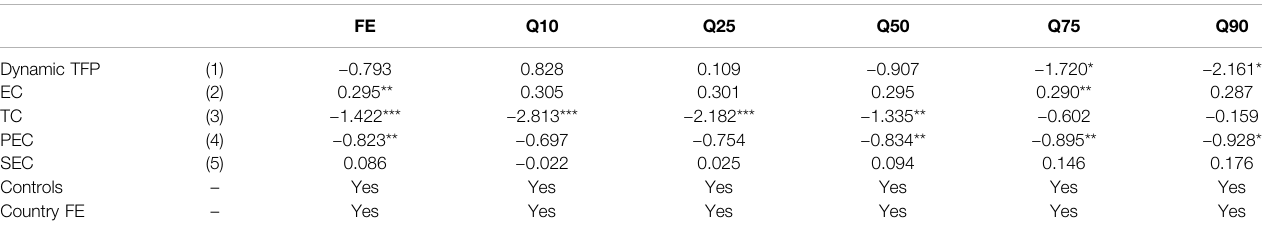
TABLE 4 | The estimation results for the fi xed-effect and MM-QR